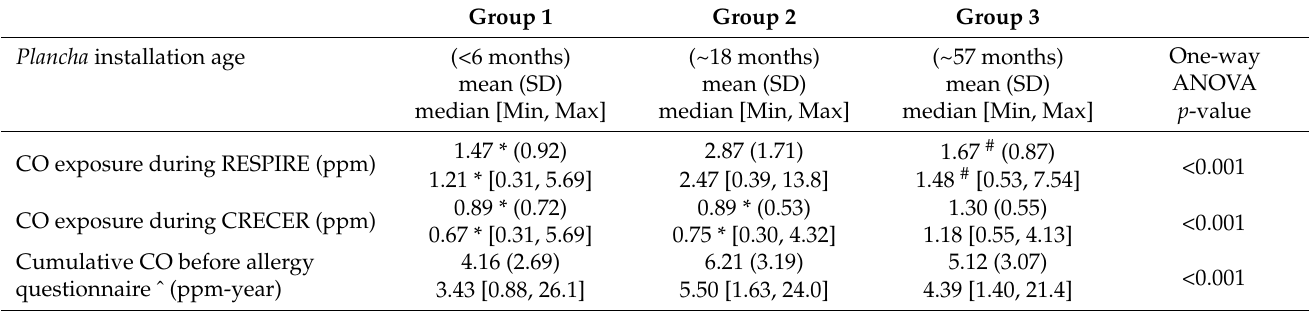
Table 2. Carbon monoxide (CO) exposure levels during RESPIRE and CRECER, and cumulative CO exposure before allergy questionnaire by study group. Group 1 Group 2 Group 3